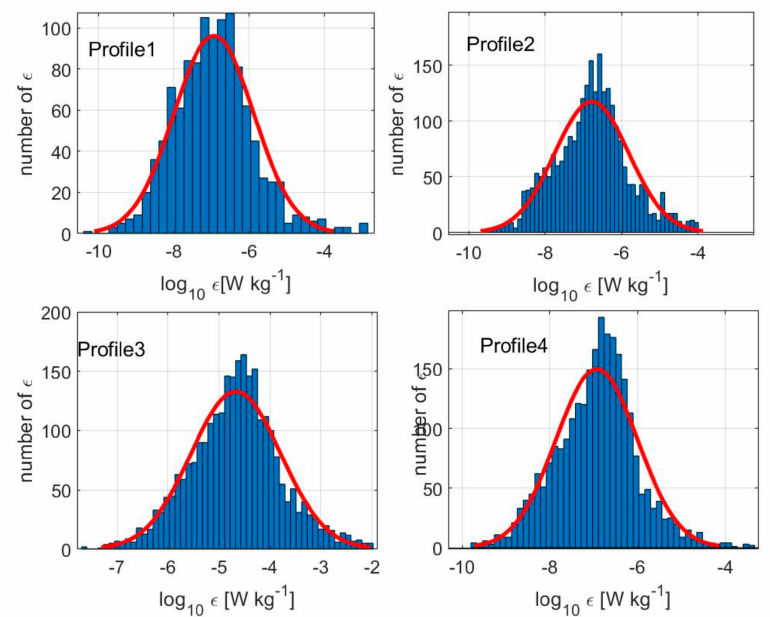
Figure 9. Probability distribution of dissipation rates for four profiles. The x -axis is the dissipation rates ( ε ) of turbulence energy and the y -axis is the number of ε distributed at each interval. The red line shows the fitting cures for dissipation rates.